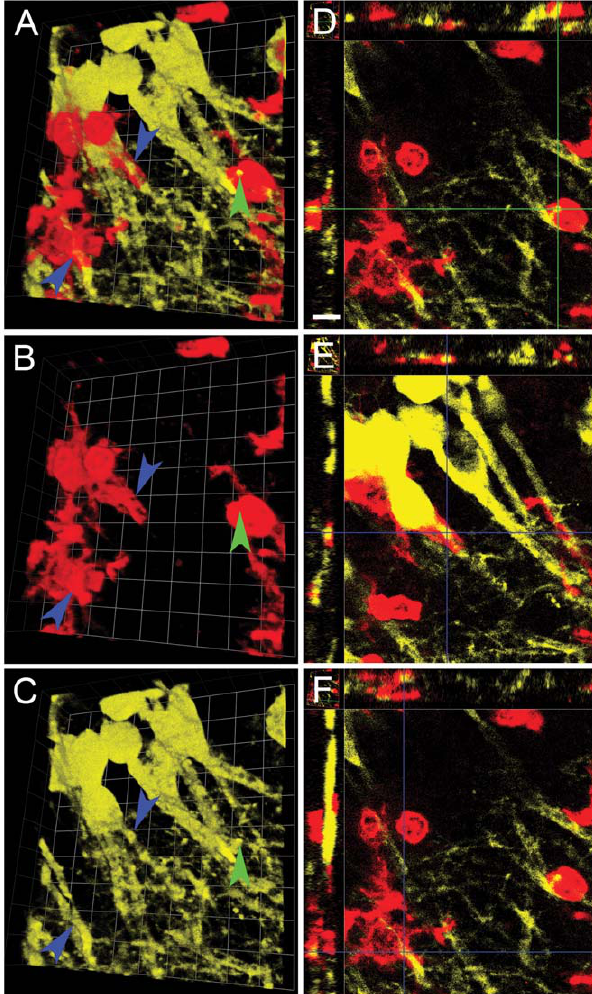
Figure 9. Stereotactic injection of Tat induces infiltrating leukocyte engulfment of dendrites. This is a montage of 3D reconstruction micrographs of a representative tissue section of right hippocampus of YFP H mice that received Tat and were sacrificed 24 hours later (n=3 independent replicates). As in Figure 7, Panels A–C depict a 3D reconstruction of CD11b + microglia (red) and infiltrating leukocytes (also red) interacting with YFP + pyramidal neurons (yellow) while Panels D–F show XYZ views at different depths in the same image stack. Green arrowhead points to an infiltrating leukocyte phagocytos- ing a dendritic process from an YFP + pyramidal neuron, which is depicted in the XYZ view in Panel D (crossing point of the two green cursor lines). In contrast, blue arrowheads identify where microglia processes appear to ensheath neuronal processes. Panels E and F depict the XYZ view of this microglial ensheathment of a neuronal process (crossing point of the two blue cursor lines). Each side of individual grid=9 m m in Panels A–C, and scale bar in Panel D=10 m m for Panels D–F. doi:10.1371/journal.pone.0023915.g009 of dendritic architecture [56]. However, in the setting of Tat- induced neuronal damage and neuroinflammation, it is quite possible that their ability to strip synapses may become amplified to a pathologic level - with the result that microglia may elicit enduring neurotoxic responses [57]. Our morphometric data (Figure S2, Panel D) demonstrate a 41% increase in leukocyte and microglial contact with neuronal structures, and when considered in the context of synaptic elements present as inclusions in